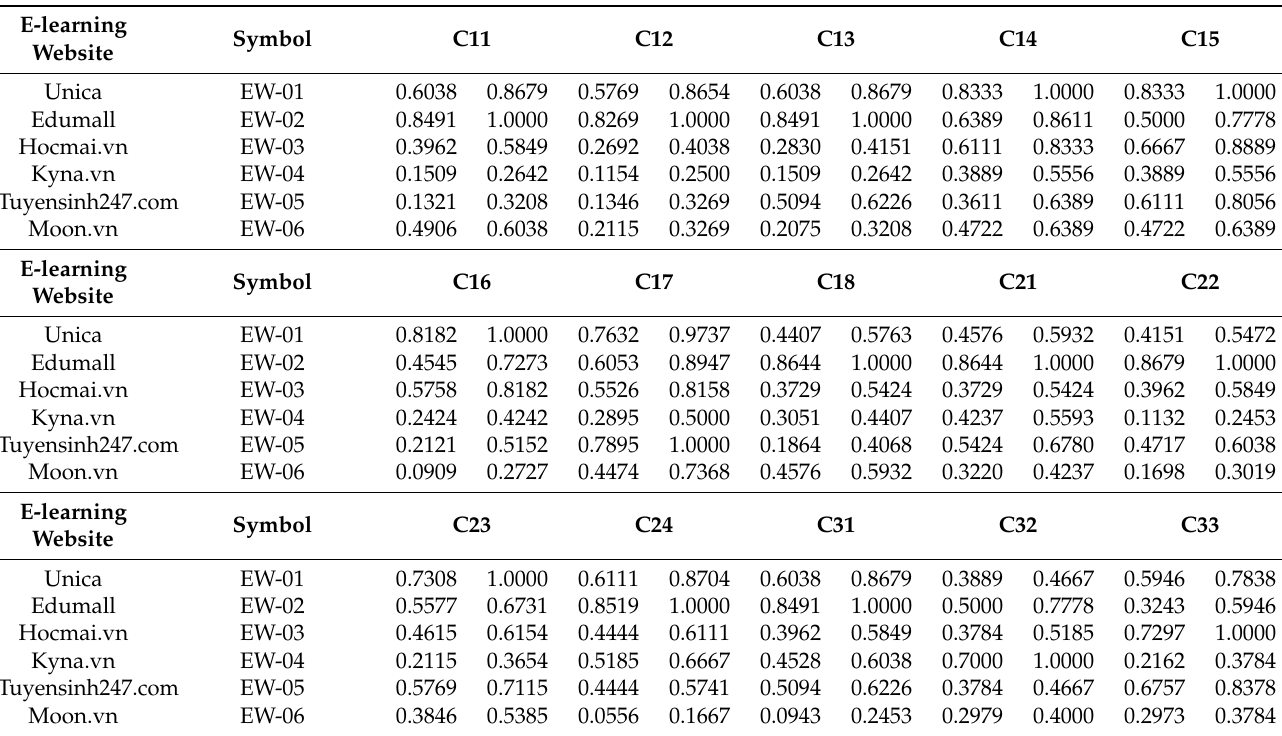
Table A2. The normalized grey decision matrix used in the G-TOPSIS